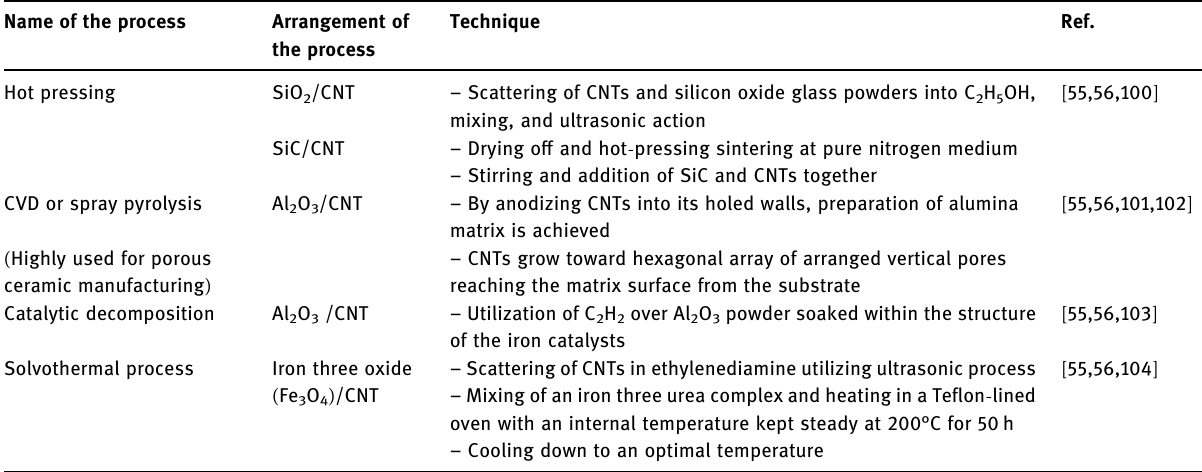
Table 8: Distinctive manufacturing ways of CMNCs Name of the process